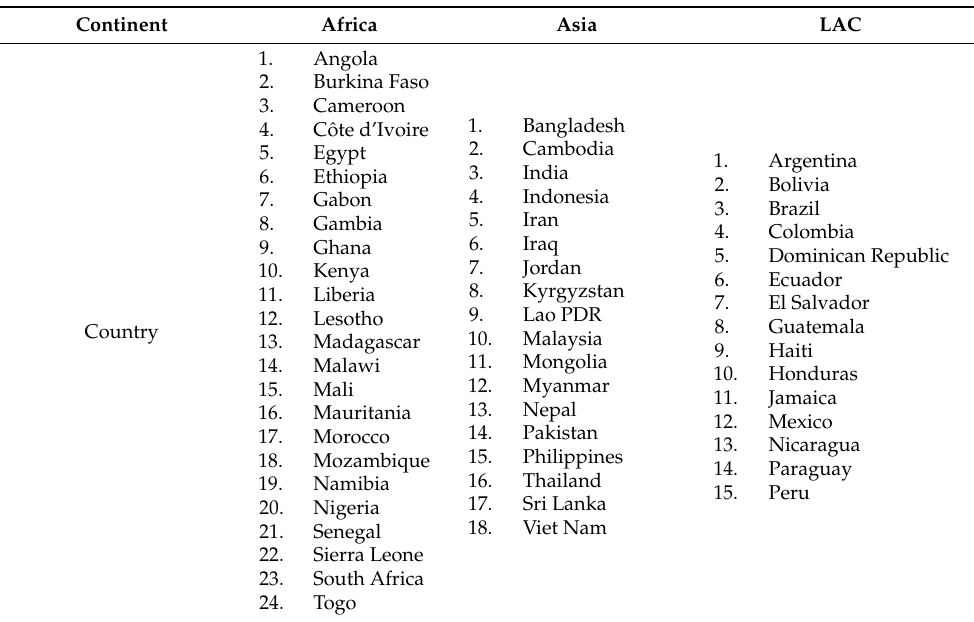
1. Argentina 2. Bolivia 3. Brazil 4. Colombia 5. Dominican Republic 6. Ecuador 7. El Salvador 8. Guatemala 9. Haiti 10. Honduras 11. Jamaica 12. Mexico 13. Nicaragua 14. Paraguay 15.